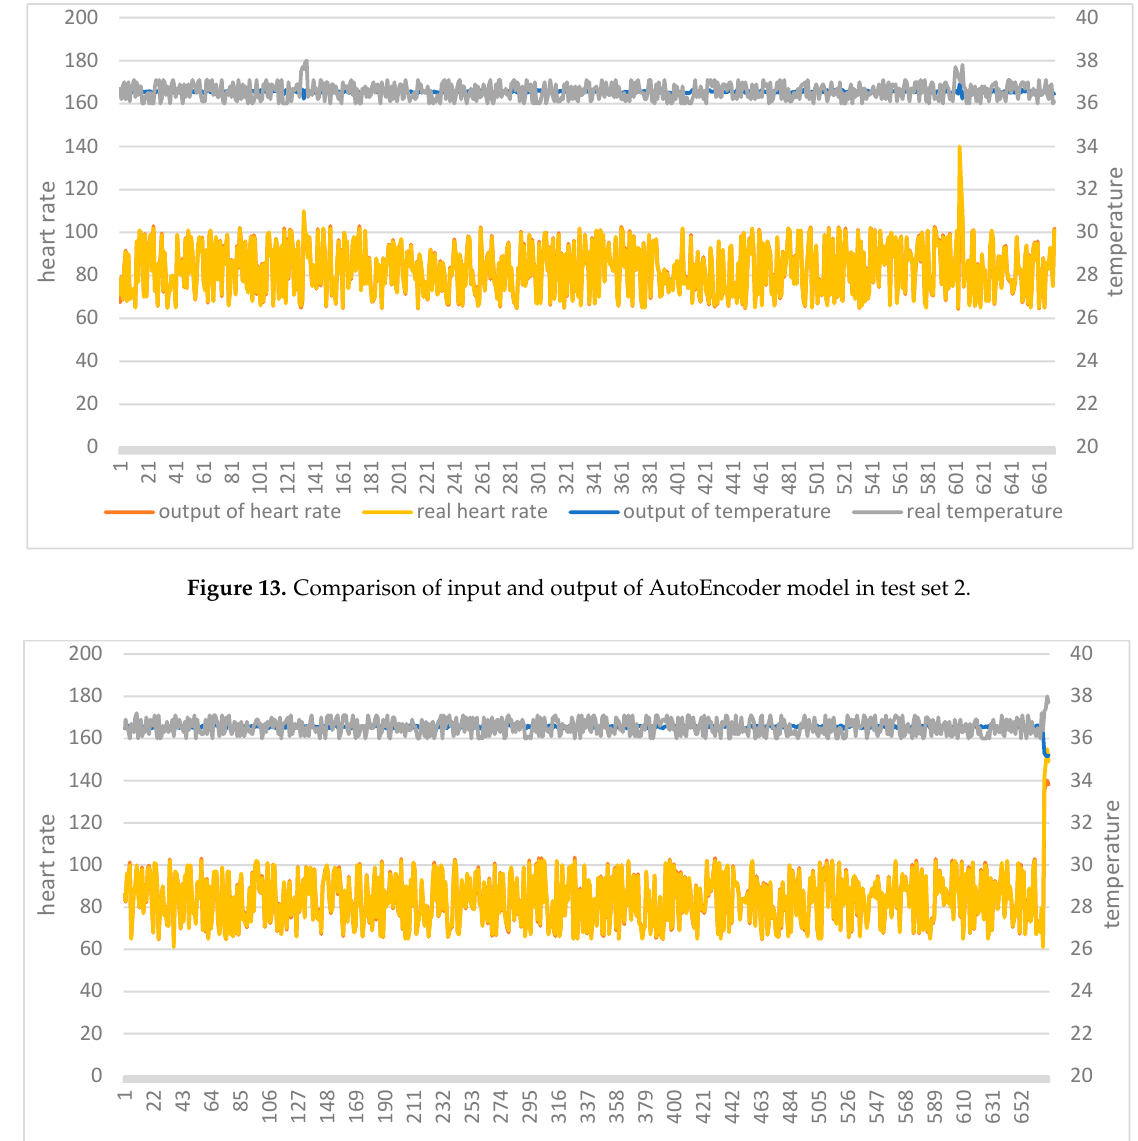
Figure 12. Comparison of input and output of AutoEncoder model in test set 1.